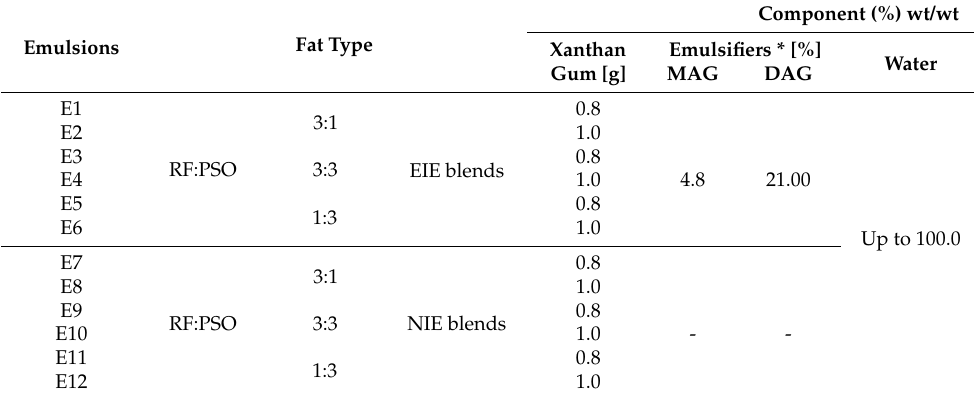
Table 1. Composition and type of produced